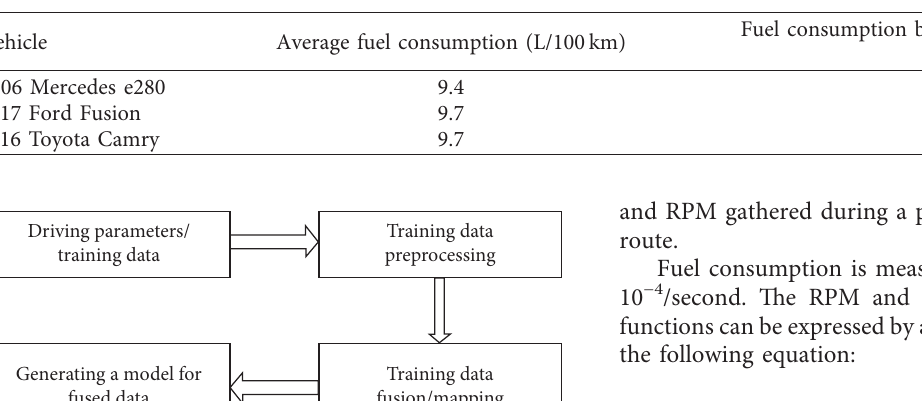
Figure 3: (a) Vehicle speed. (b) MAF Readings. Table 4: Obtained fuel consumption vs. claimed fuel consumption.